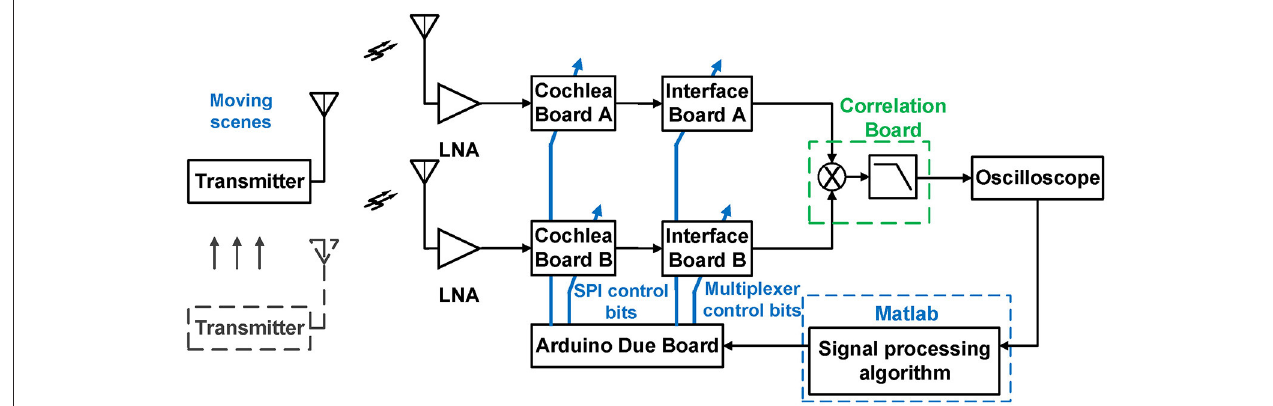
FIGURE 10 | Block diagram of an experimental prototype of a two-channel RF scene analysis system based on two RF cochlea chips.